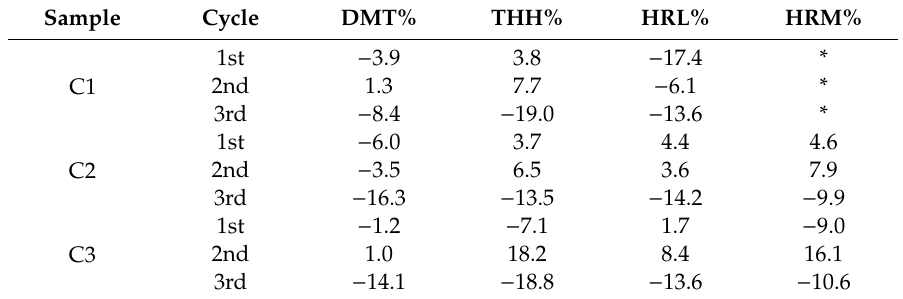
Table1. PercentageofvariationforDMT,THH,HRL,andHRMaftereachofthethreefreeze–thawcycles. Table 1. Percentage of variation for DMT, THH, HRL, and HRM after each of the three freeze–thaw cycles. Sample Cycle Sample Cycle DMT%